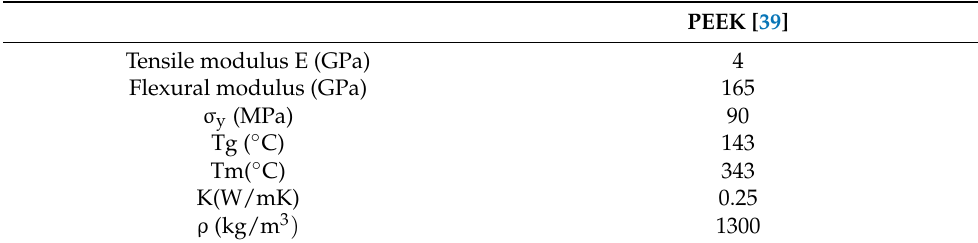
Table 4. Materials properties referred to injection-molded